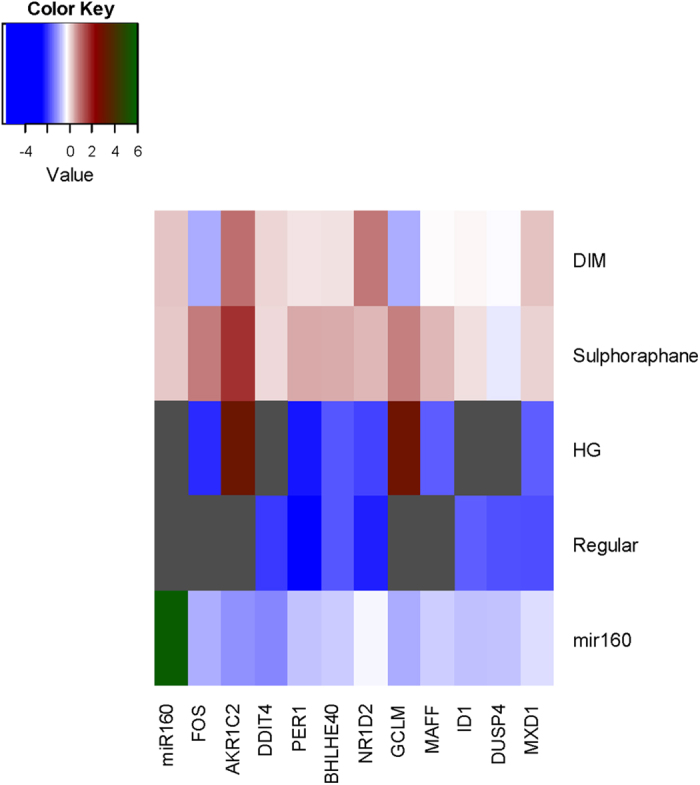
Heatmap of deregulated genes in gastric biopsies or gastric cancer cell line.The figure shows fold change for 11 genes and miR160 in 5 set of samples. High glucosinolate (HG) and regular represent samples from gastric biopsies after ingestion of HG (enriched in sulforaphane) or regular broccoli as per Gasper et al.22, and fold change data is collected from the same paper. Sulforaphane, DIM and miR160 refer to MNK45 cell line treated with each of the named molecules, and fold change was measured by real time PCR (log transformed to be comparable to Gasper et al. fold change). Blue blocks represent downregulated genes, red to green blocks upregulated ones. Grey blocks are missing values from Gasper et al. paper.